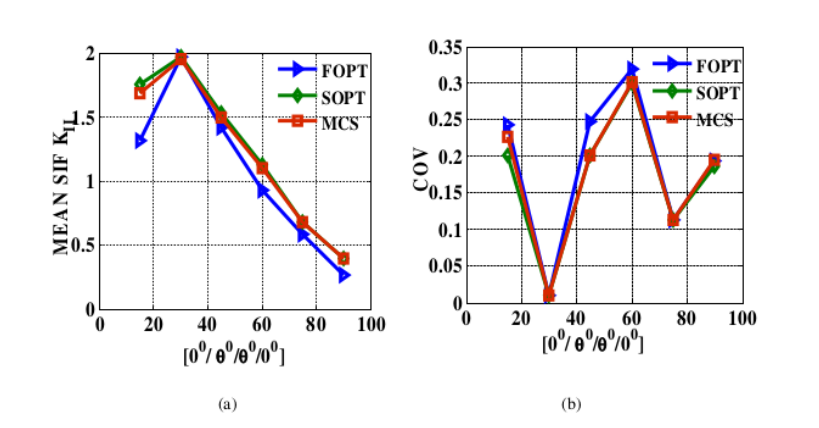
Figure 5: Effect of different lamination angles with random change in crack opening ( co ) on (a) mean of SIF K II and (b) COV of SIF K II